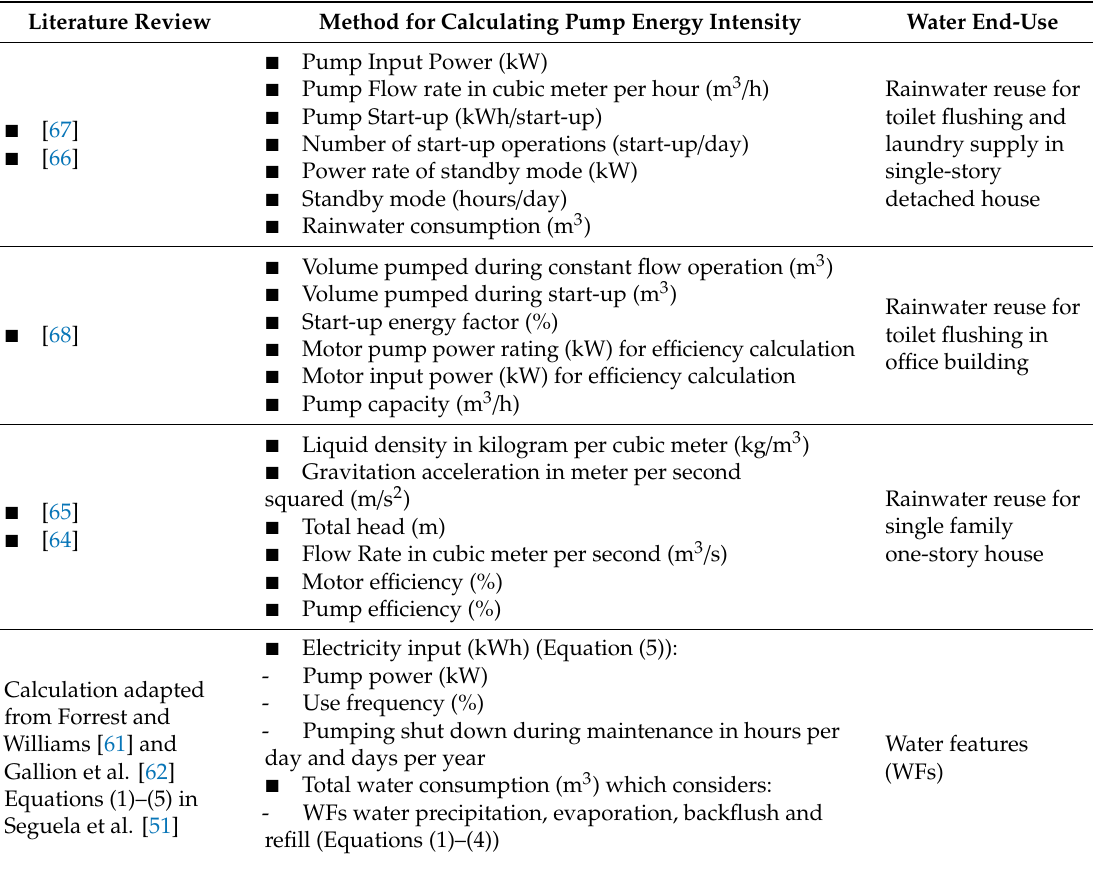
Table 4. MFCS energy in water calculation